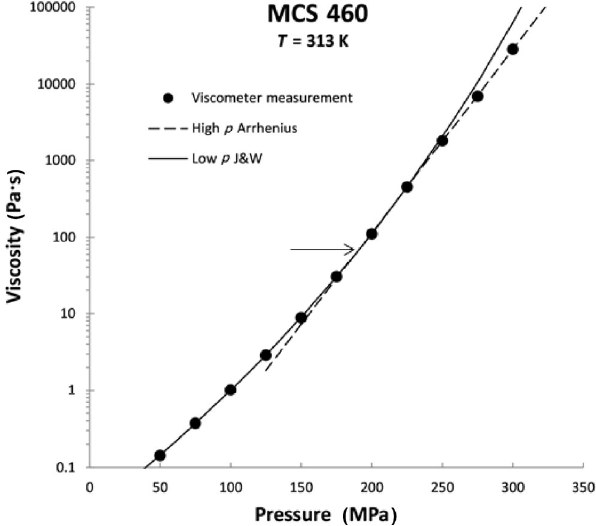
Fig. 5 The pressure dependence at 313 K showing a crossover (at the horizontal arrow) which can be best represented by two J&W equations (4).